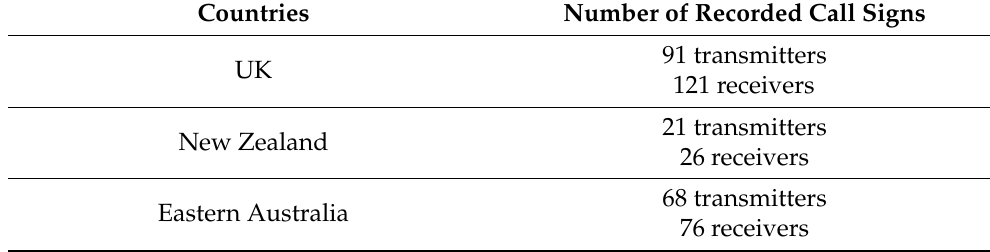
Table 4. Number of radio stations which have established links between the UK and New Zealand, and between the UK and Eastern Australia in the WSPR database in 2017. Eastern Australia was added in to achieve similar numbers of transmitters and